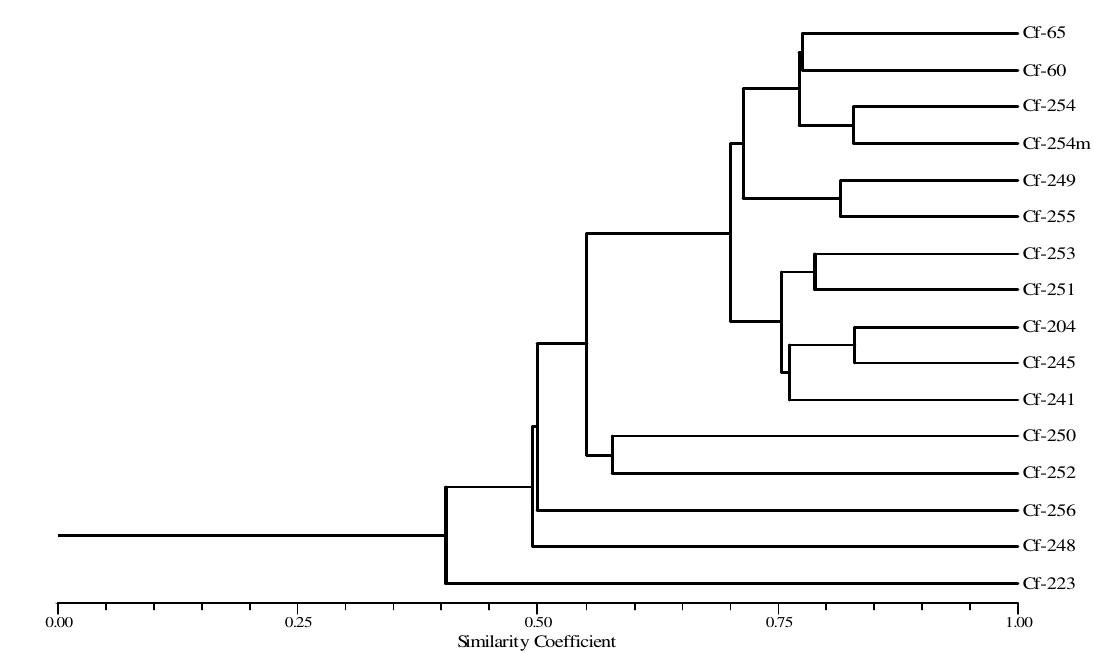
Fig. 2. Dendrogram obtained by unweighted paired group method showing molecular diversity among different isolates of Colletotrichum falcatum Tab. 6. Similarity matrix generated by Jaccard ’ s coefficient using molecular data Isolate No.